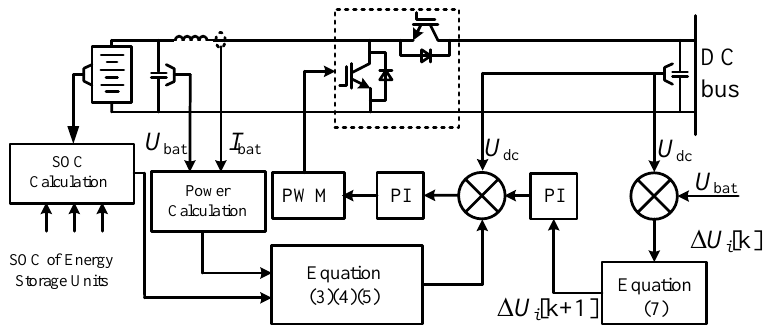
Figure 7. ESU control principle.